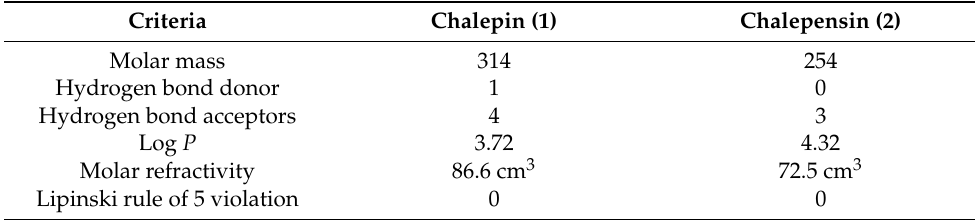
Table 3. “ Druglikeness” of chalepin ( 1 ) and chalepensin ( 2 ) *. Criteria Chalepin